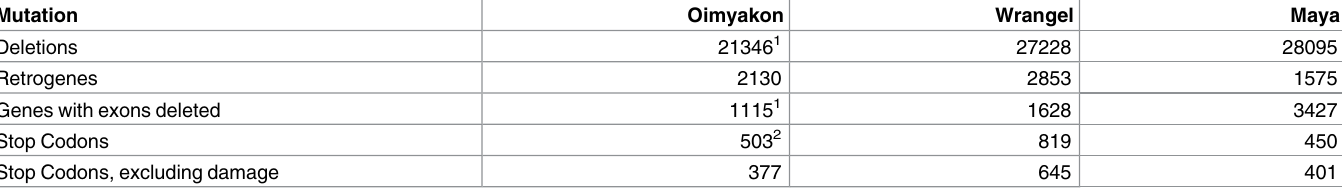
Table 1. Mutations identified in mammoth